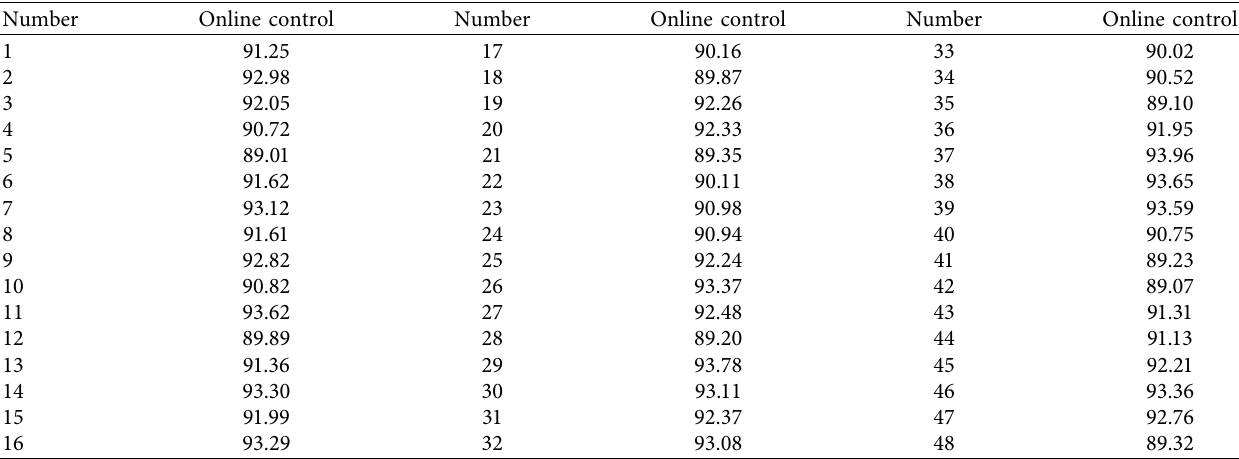
Table 1: Online control effect of small- and medium-sized electromechanical